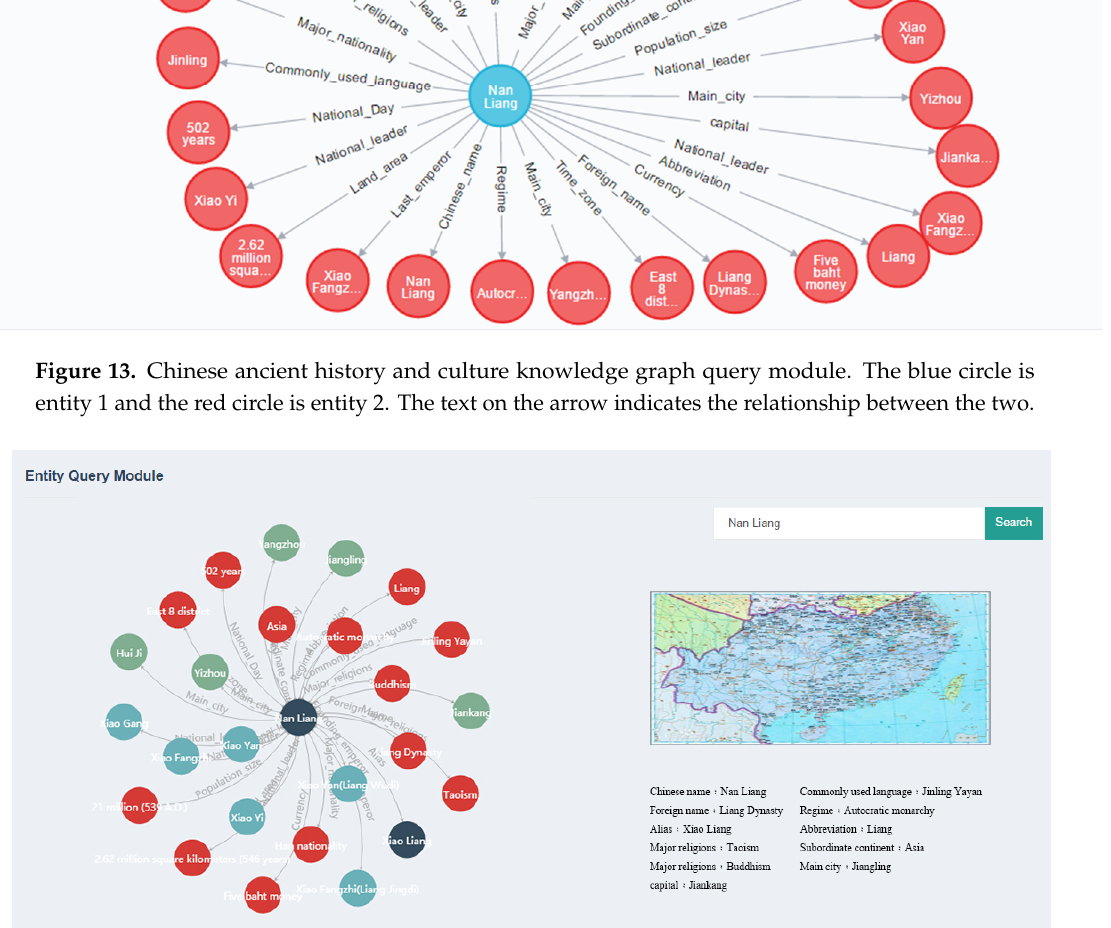
Figure 14. Entity attribute knowledge query module, the left is the force-oriented diagram of the query entity, and the right is the encyclopedia introduction of the query entity.